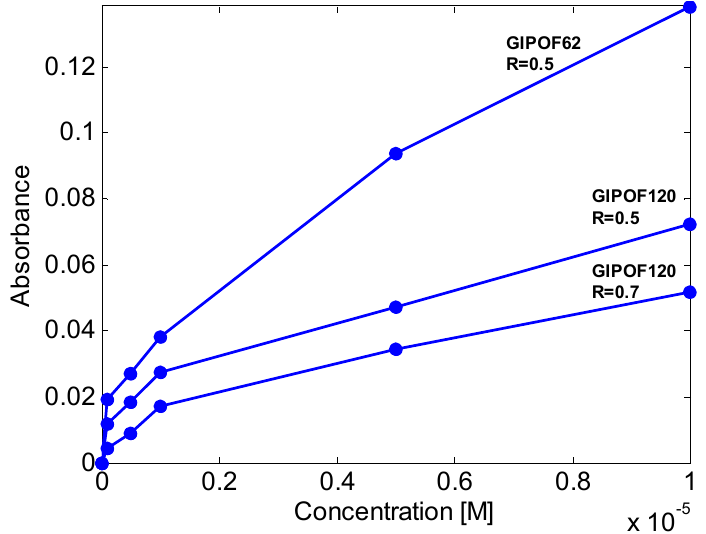
Figure 7. Experimental results of the absorbance